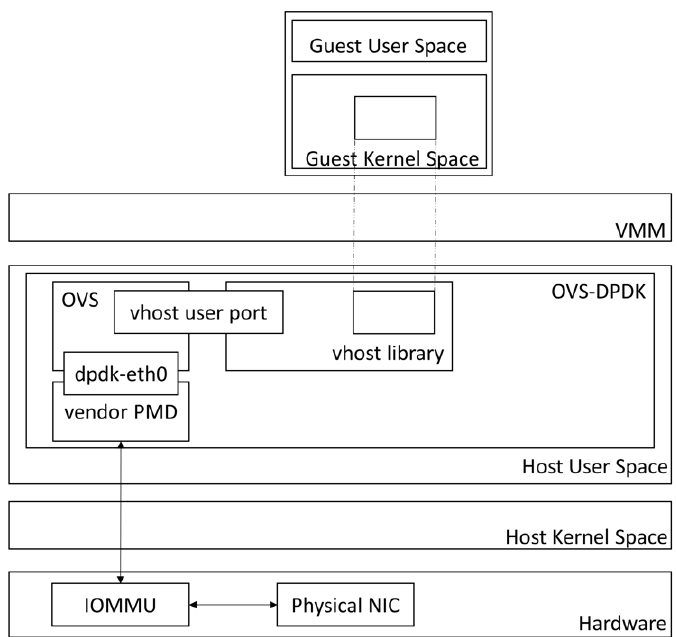
Figure 3. Network architecture of OVS-DPDK.